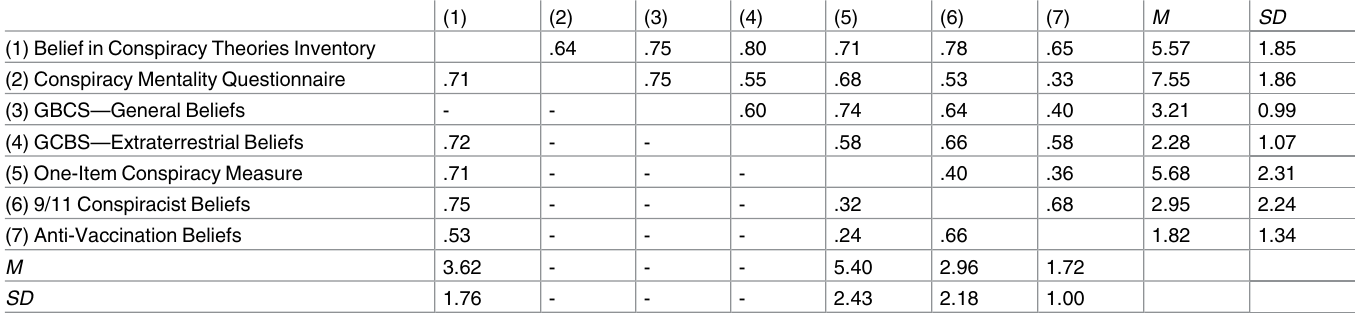
Table 7. Bivariate Correlations between all measuresincluded in the present study (EFA Split-Half Subsample in the Top Diagonal, CFA Split-Half Subsample in the Bottom